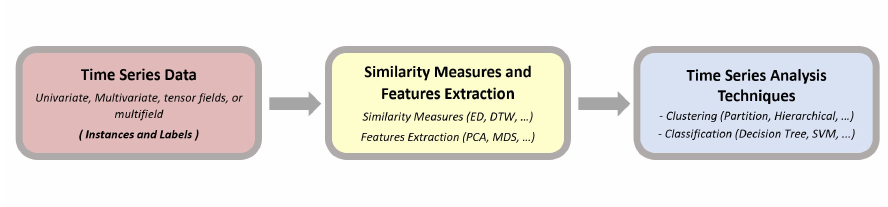
Figure 2. The pipeline of conventional time-series